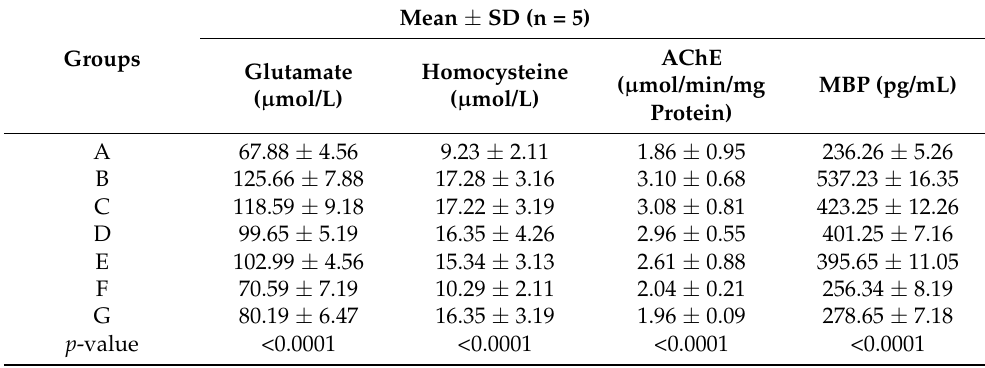
Table 6. Protein Profile Of LPS Induced Multiple Sclerotic Wistar Rats.